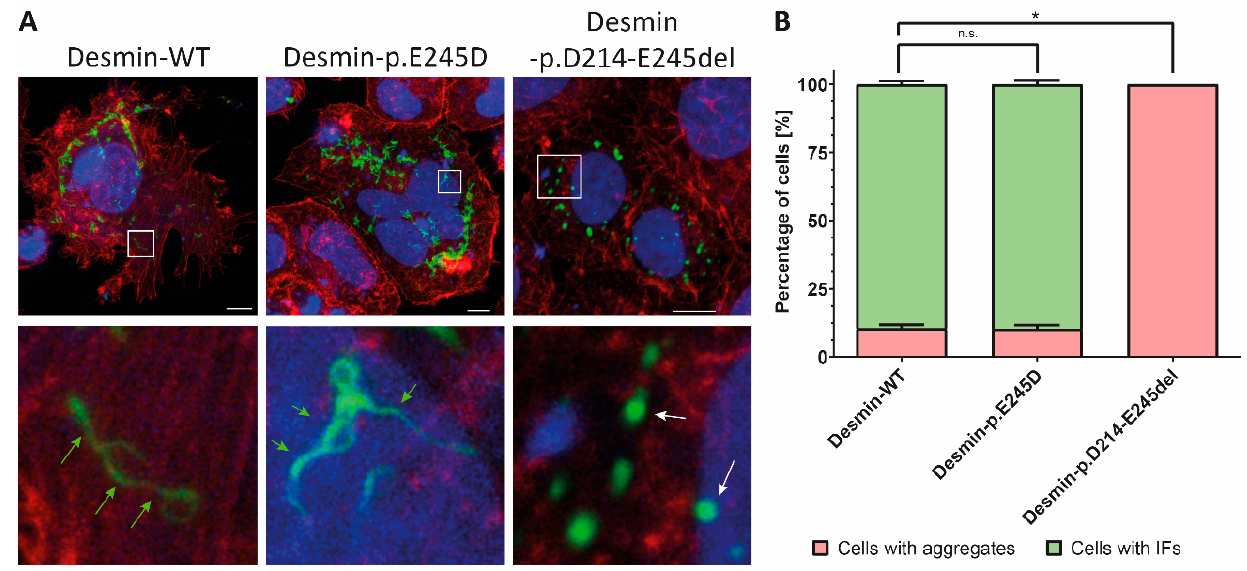
Figure 6. ( A ) Fluorescence analysis of transfected SW13 cells. Of note, desmin-p.D214-E245del causes severe desmin aggregation (white arrows), whereas wild-type and desmin-p.E245D form intermediate filaments (green arrows). Desmin is expressed as a fusion protein with EYFP (shown in green). F-actin is stained using phalloidin conjugated with Texas-Red (red) and nuclei are stained using DAPI (shown in blue). Scale bars represent 10 µm. ( B ) Quantification of desmin aggregate formation in transfected cells. About 100 cells have been analyzed per transfection experiment ( n = 4). Error bars represent SD. Non-parametric Mann–Whitney-U-test was used for statistical analysis. n.s. = not significant; * indicate p -values < 0.05.